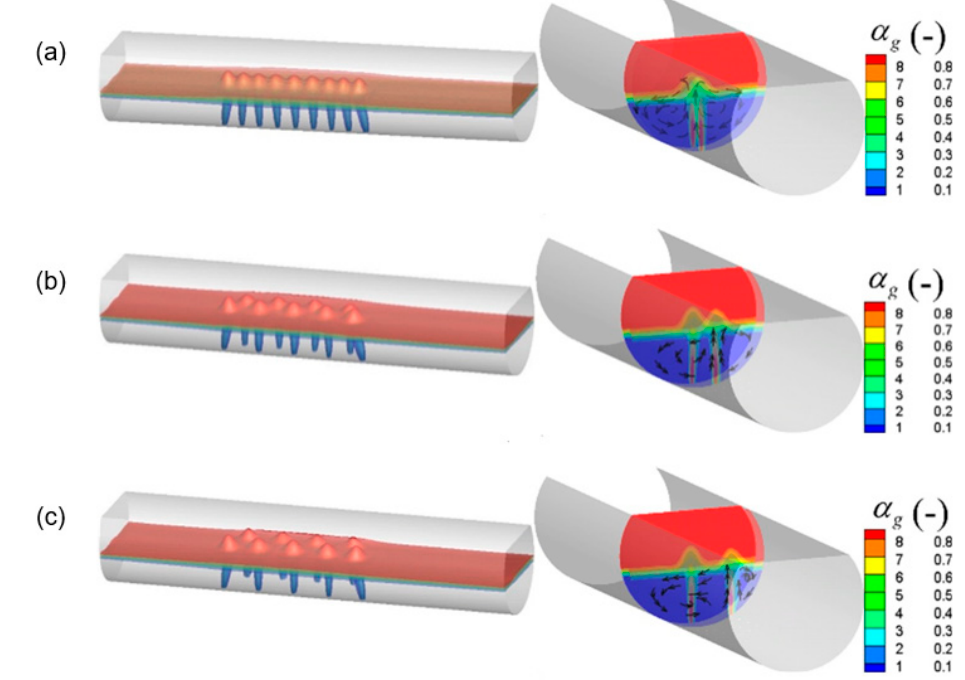
Figure 7. Predicted typical local gas volume fraction in the bath with different nozzle arrangements, where the β A is 0 ° , and the β B is ( a ) 0 ° , ( b ) 14 ° , and ( c ) 28 ° , respectively.